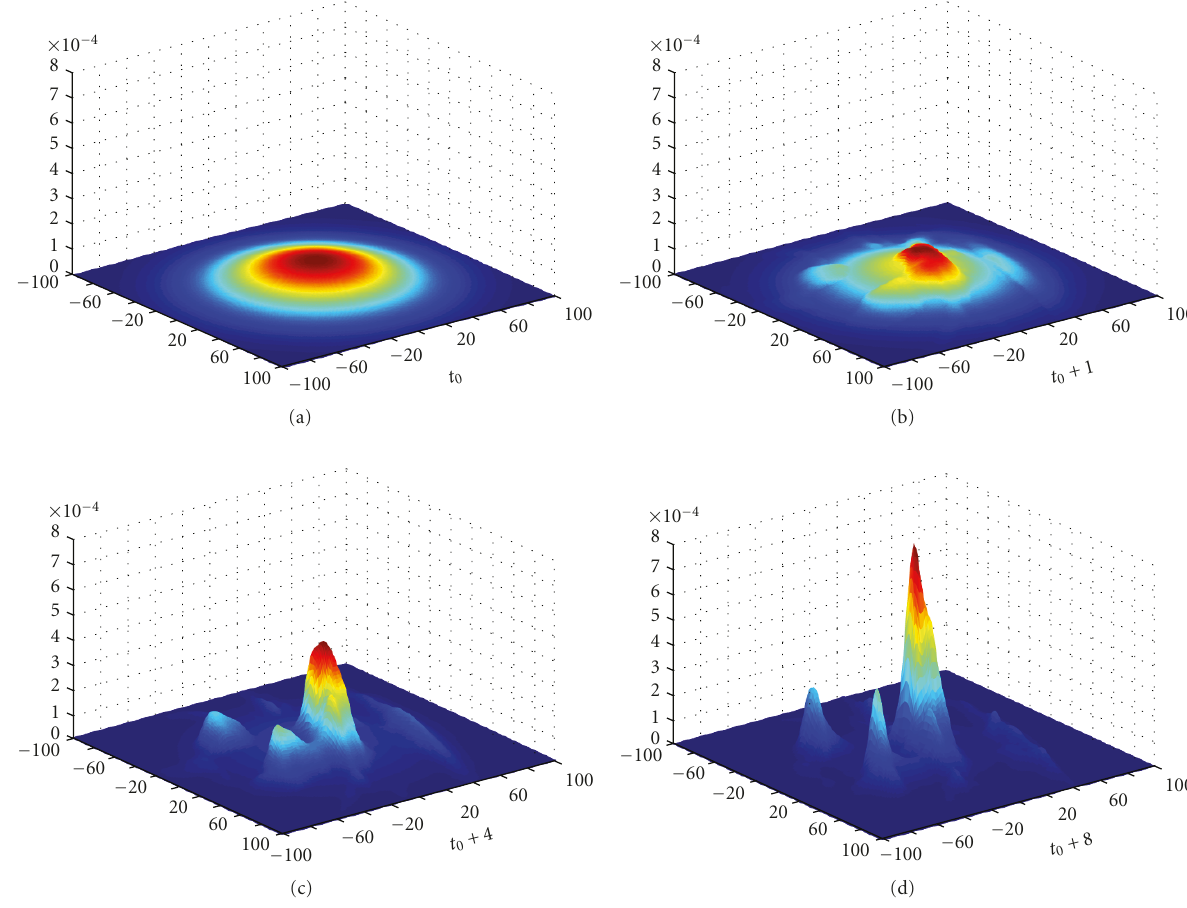
Figure 6: Evolution of the filter’s probability density function (PDF). The capability of the filter to maintain the full probability distribution over the grid space can be